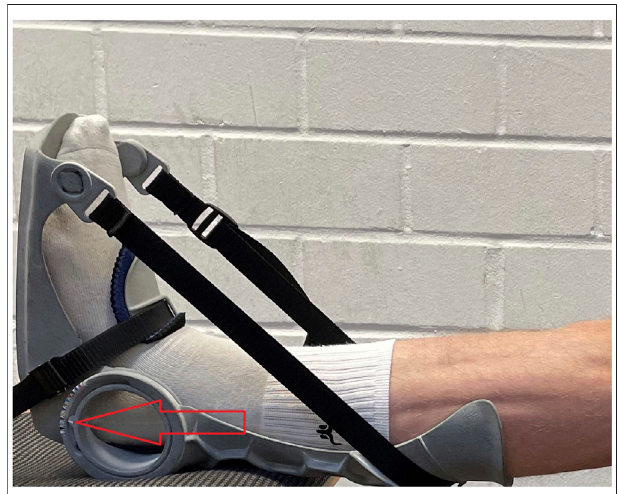
FIGURE 5 | Measuring device for maximal dorsi fl exion via goniometer attached to the